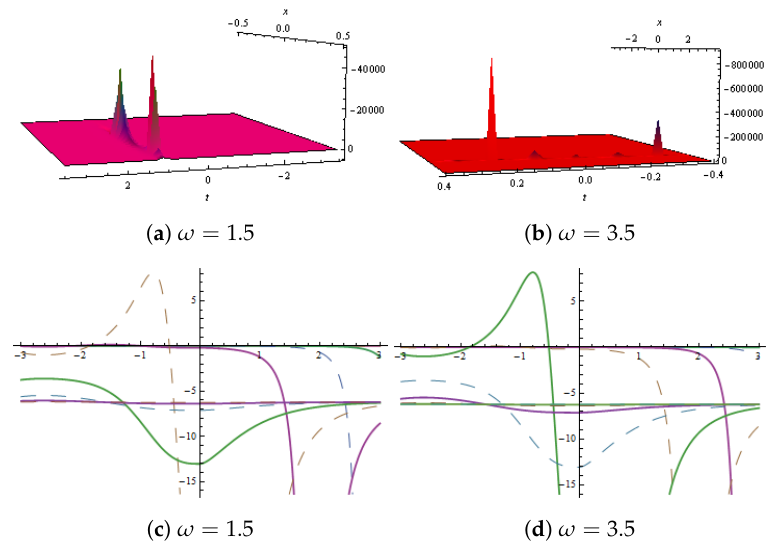
Figure 19. ( a , b ) show 3D plots and ( c , d ) show 2D